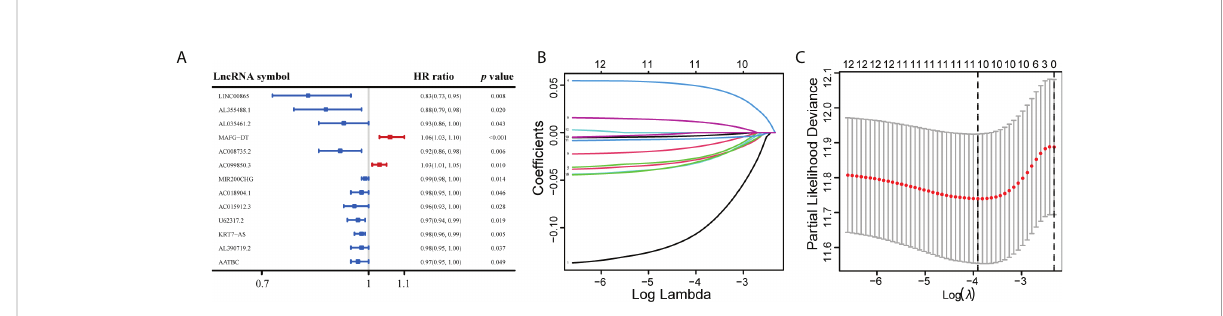
FIGURE 3 Identifying ERS-related lncRNAs associated to OS. (A) The forest plot recognized 13 ERS-related lncRNAs substantially associated with OS. (B) Lasso regression analysis. (C) The LASSO coef fi cient spectrum for lncRNA associated with OS was